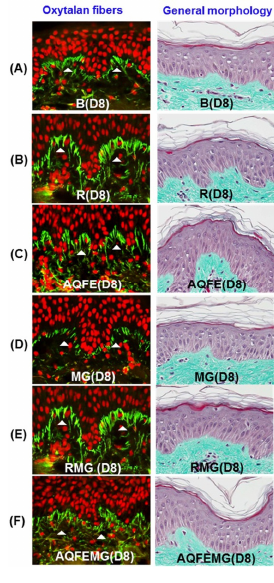
Figure 2. Cont. Figure 2.